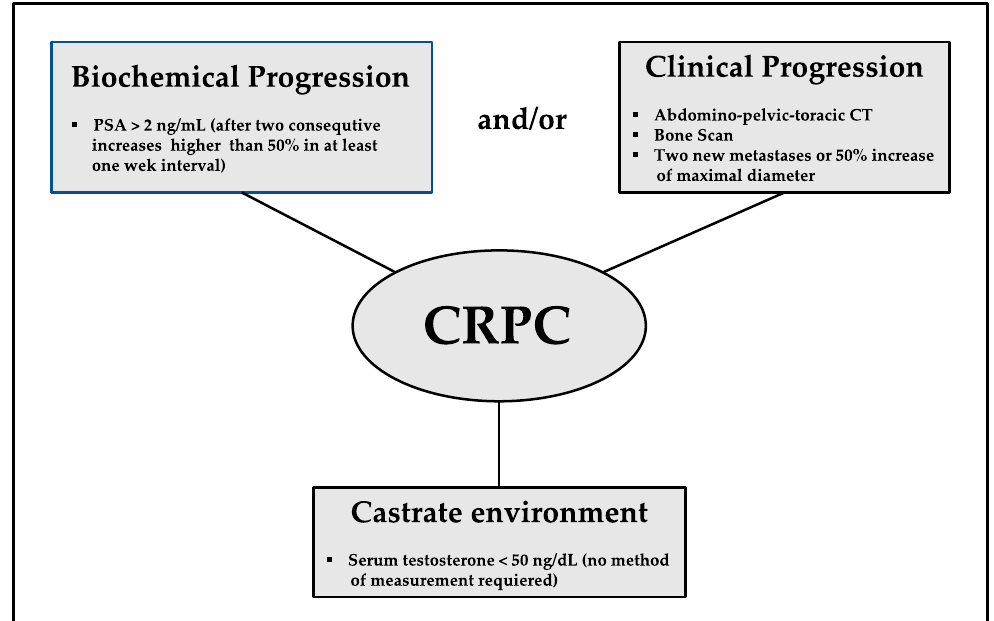
Figure 1. Current definition of Castrate Resistant Prostate Cancer.